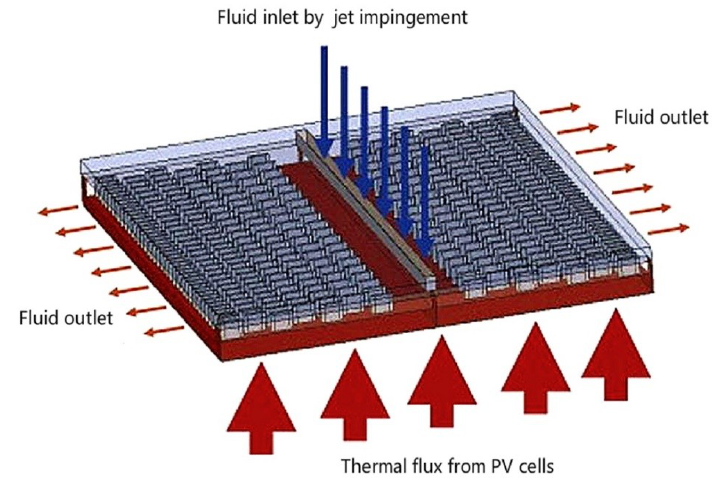
Figure 23. Principle and operation of the hybrid cooling device [103].